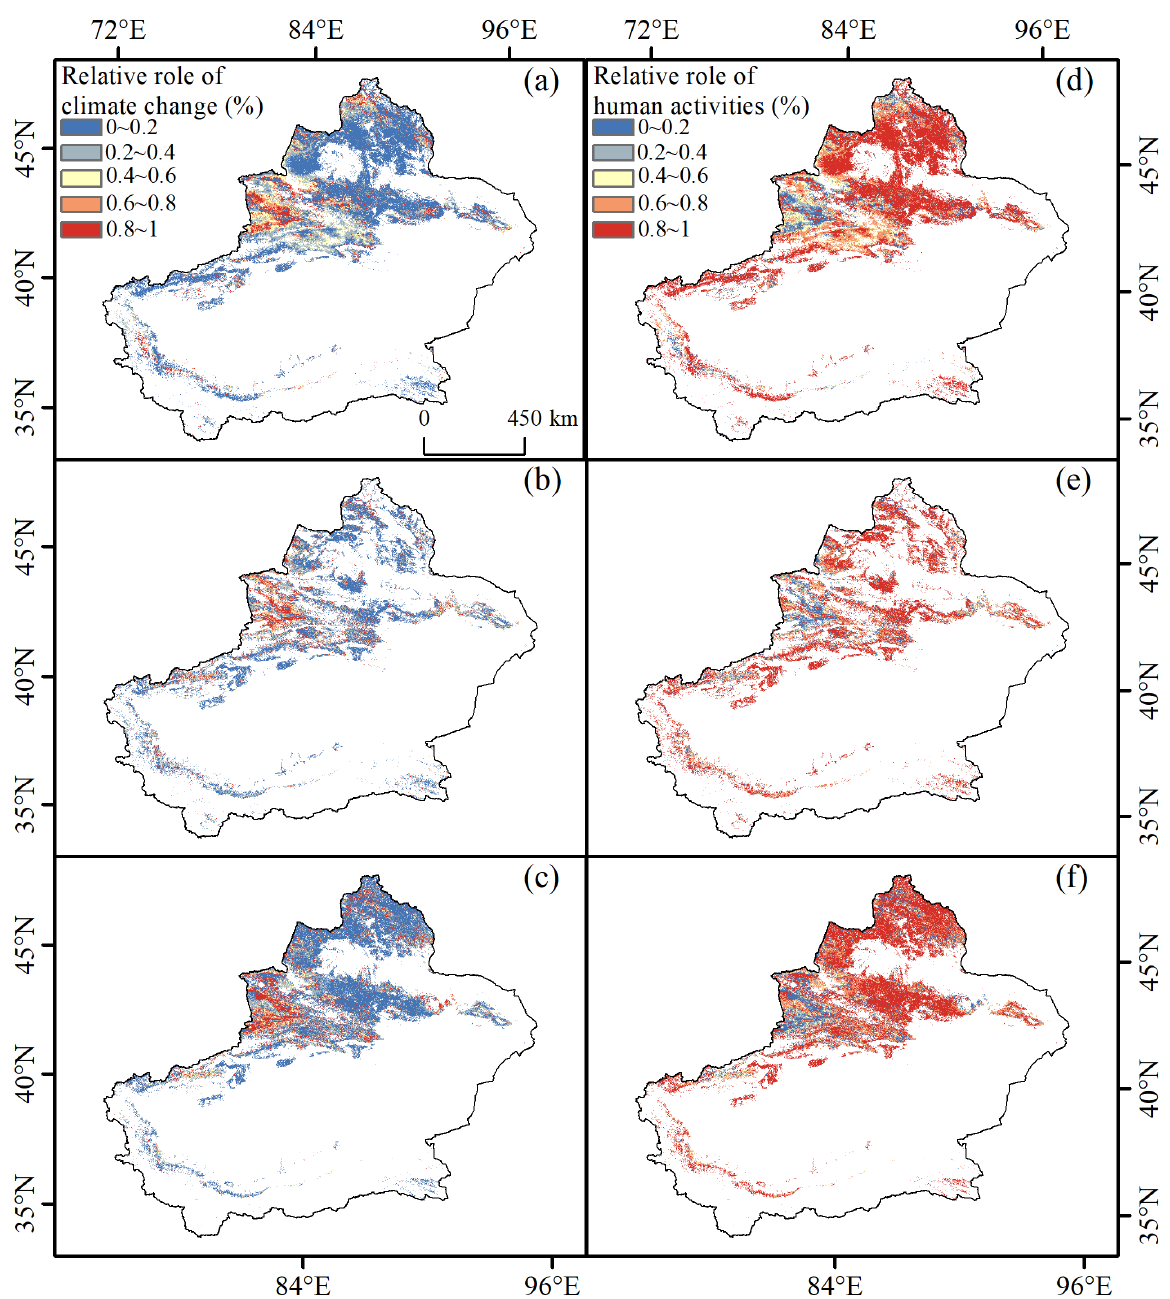
Figure 14. Spatial distribution of the relative role of climate change and human activities on the variation in the ecosystem indicators from 2001 to 2015. ( a ) Relative role of climate change in ET, ( b ) Relative role of climate change in GPP, ( c ) Relative role of climate change in LAI, ( d ) Relative role of human activities in ET, ( e ) Relative role of human activities in GPP, and ( f ) Relative role of human activities in LAI. Note: PRE used the optimum precipitation accumulation period.